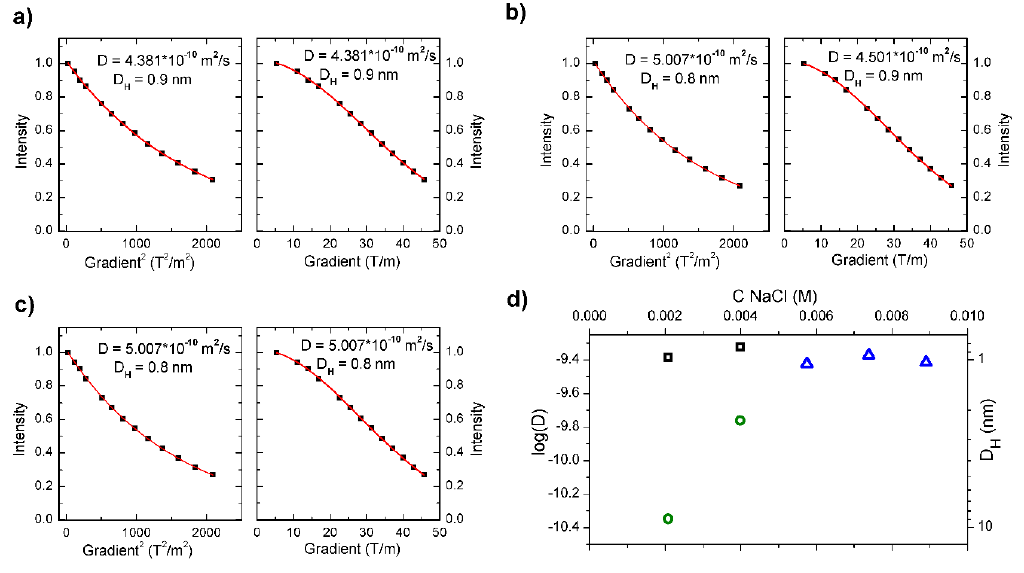
Figure 3. Effect of NaCl and CaCl 2 on self-organization of PAA-g-C 16 OH(40%) (c = 45 mg/mL samples containing 0.05 M ( a ) and 0.15 M NaCl ( b ) as well as 0.05 M CaCl 2 ( c ), along with calculated diffusion coefficients (log(D)) and hydrodynamic diameters (D H ) plotted versus concentration of NaCl ( d ). Intramolecular pseudo-micelles (smaller fraction of aggregates) are denoted by black squares (for bimodal distribution) and blue triangles (for unimodal distribution), while larger aggregates by green circles.